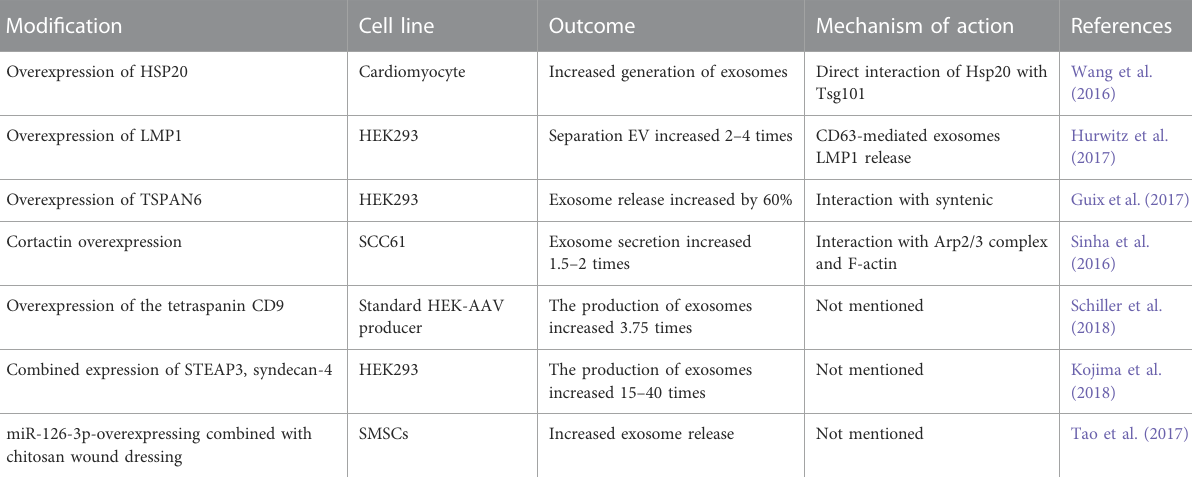
TABLE 1 Take parts as an example: Gene manipulation promotes exosome